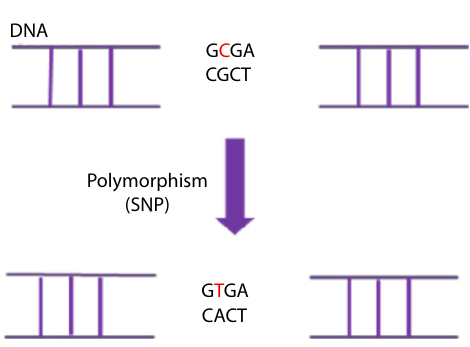
Figure 7. A Single-Nucleotide DNA Polymorphism (SNP) is defined as a single DNA variation detected when a single nucleotide in the genome (or other common sequence) is different between species or paired chromosomes in an individual. In this case there is a substitution of a C (Cytosine) in a T (Tymine) which causes the change of a G (Guanine) in a A (Adenine) in the complementary DNA strand. nucleotides [30,31]. They are considered the second most common form of variation in the human genome following SNPs, with over 3 million short indels listed in public databases. CNVs are variations in the number of copies of DNA regions. They can involve loss of one or both copies of a region of DNA, or the presence of more than two copies of this region. They can arise from